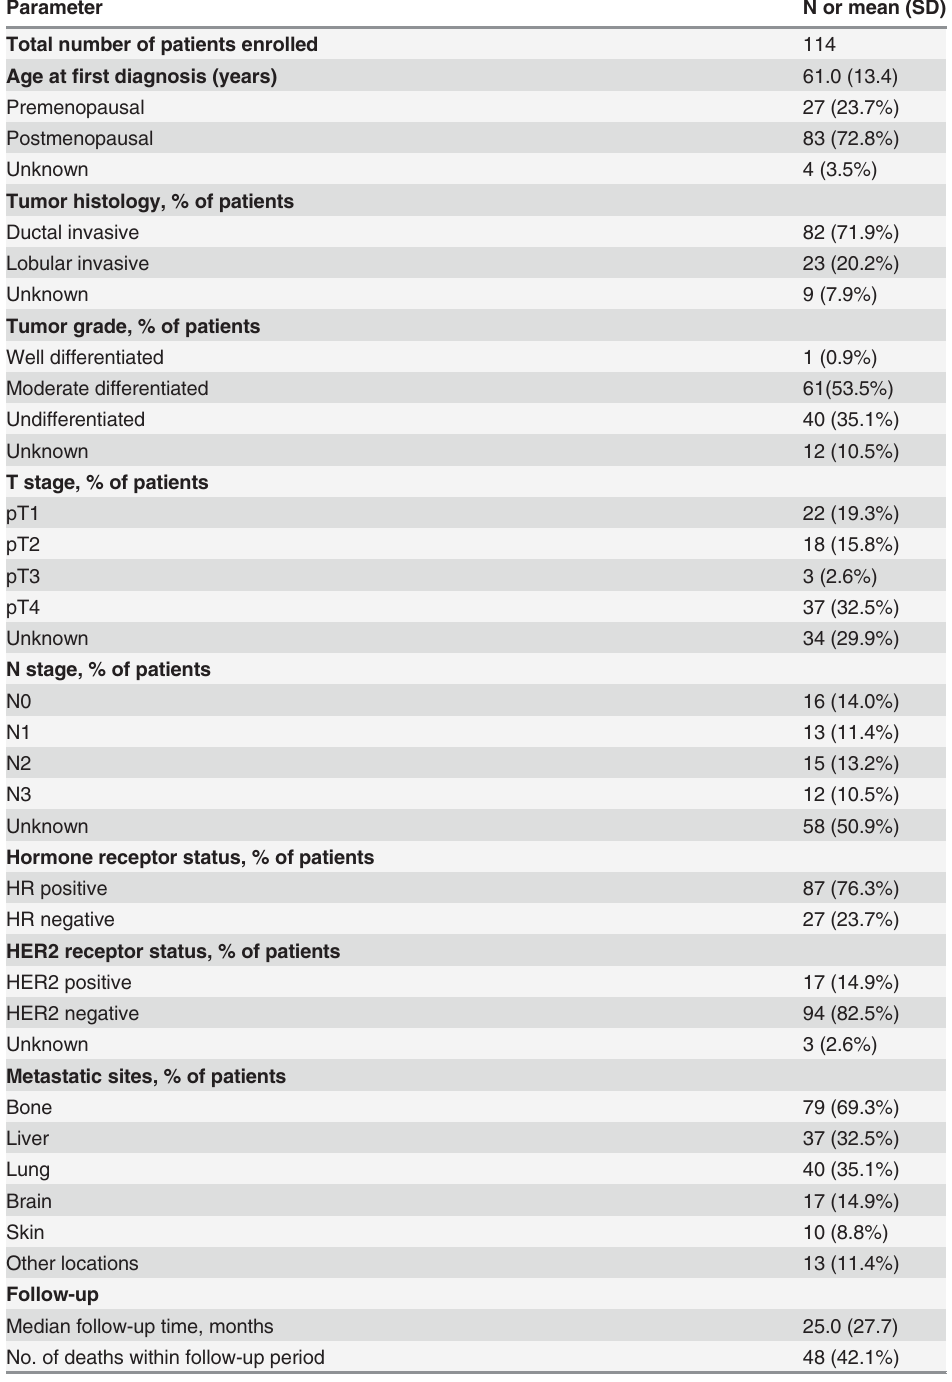
Table 1. Characteristics of 114 patients with primary metastatic breast